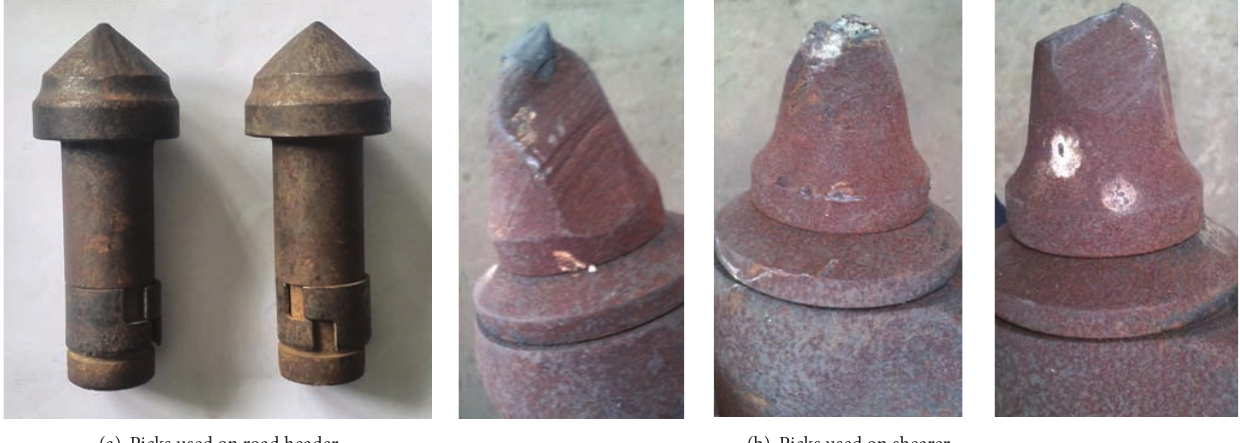
Figure 1: Picks out of